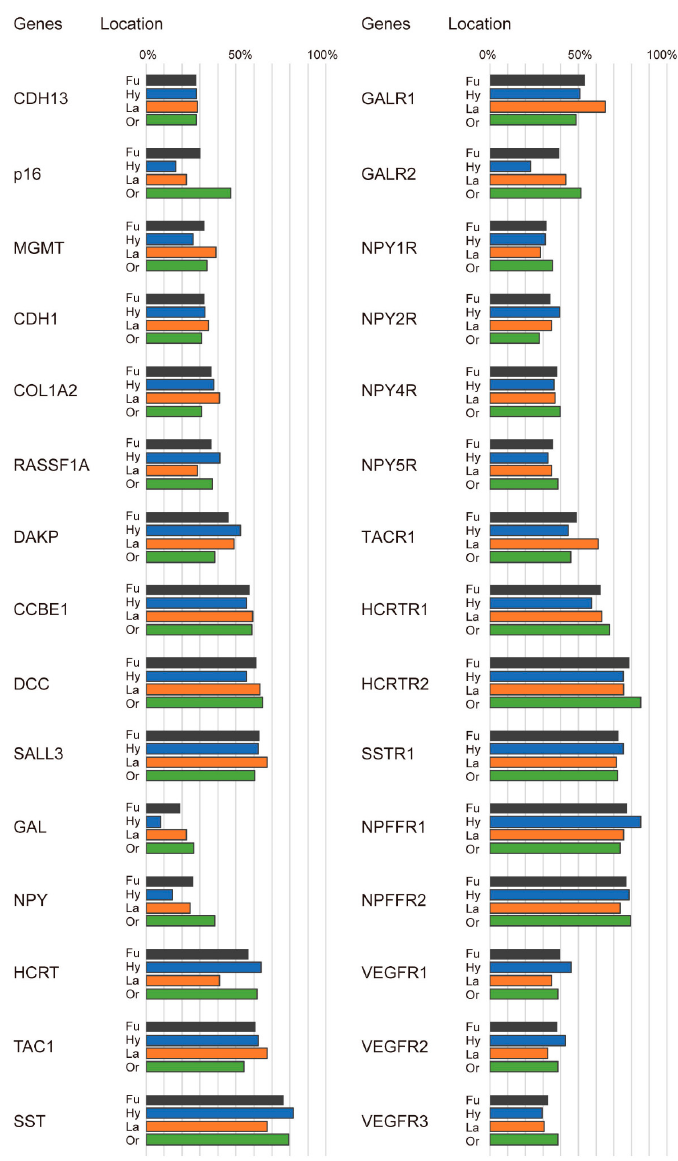
Figure 1. Summary of hypermethylation of tumor-related gene (TRG) promoters in HNSCC samples. Shown here are the methylation frequencies (%) of 30 TRGs in the cohort. Grey bars: Fu: full panel; blue bars: Hy: hypopharyngeal cancer; orange bars: La: laryngeal cancer; green bars: Or: oral cavity cancer. Table 2. Correlation between tumor sites and methylation status.